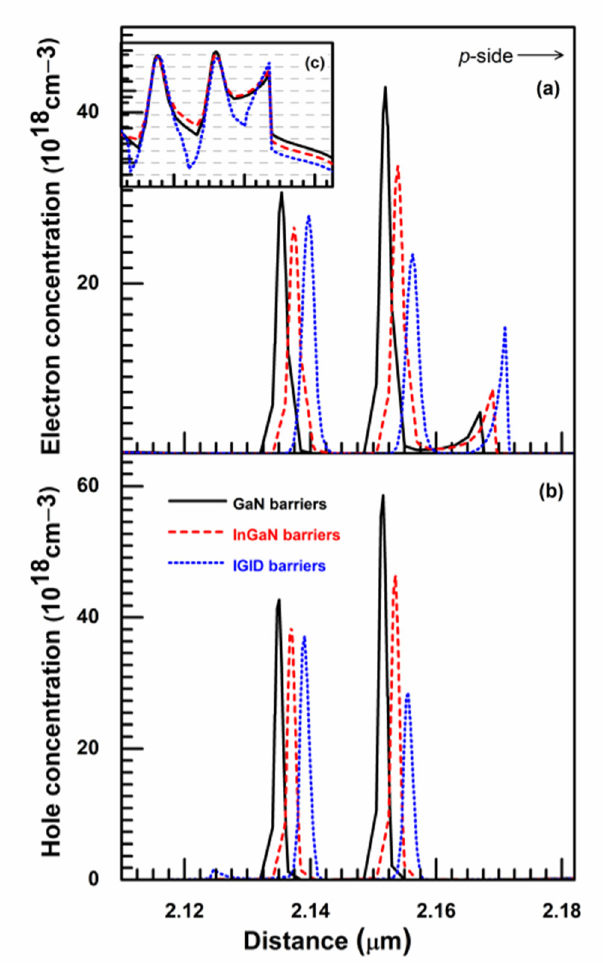
Figure 4. The electron and hole concentration distributions for the ( a ) GaN, ( b ) InGaN, and ( c ) IGID LDs at 120